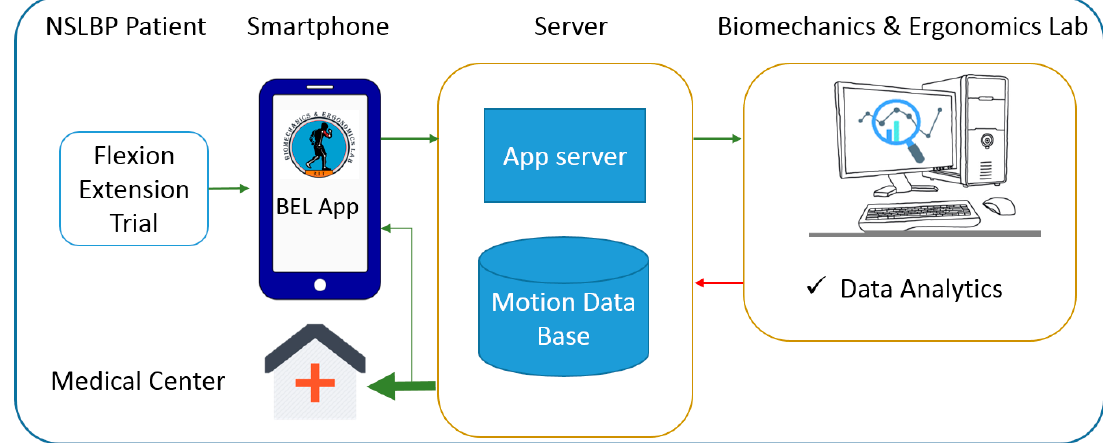
Figure 3. Schematic illustration of the data path in real-time NSLBP classification.